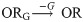
The minimal kinetic model for the odor response.a. A schematic of olfactory signaling cascades. Golf, olfactory G-protein binding to and the subsequent release of GαGTP subunit from the receptor via GDP/GTP exchange (ORG→-GOR) elicit downstream signal cascades: production of second messengers (cAMP) via stimulation of adnenylyl cyclase III, followed by depolarization of membrane potential via cAMP-induced opening of ion-channels [39, 40]. The downstream signal is stronger (the thicker arrow in purple) when odorant is bound to the OR. b. The four-parameter model (Eq 3) to describe the dose-response data.